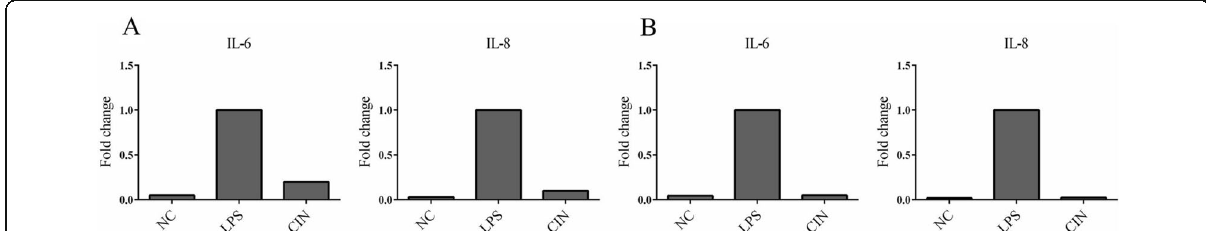
Fig. 7 Anti-inflammatory effects of CIN in LPS-stimulated MH7A cells and primary synovial cells. Realtime PCR results of 0.5 μ M of CIN on the gene expression of IL-6 and IL-8 in LPS-stimulated MH7A cells ( a ) and LPS-stimulated primary synovial cells ( b